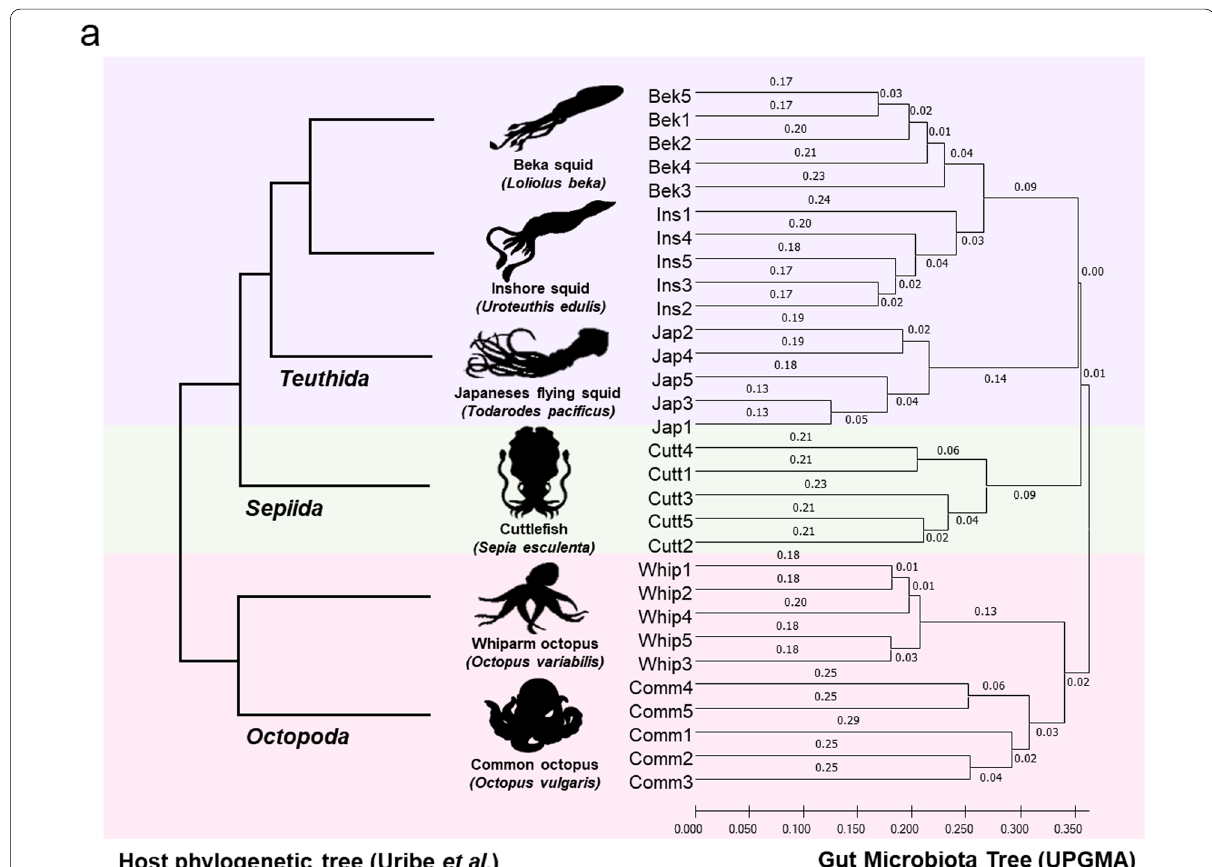
Fig. 3 Phylosymbiotic host‑gut microbiota assembly in cephalopods. a UPGMA‑clustering dendrograms for cephalopod gut microbiomes based on unweighted UniFrac distances, compared with the host phylogenetic tree based on complete host mitochondrial genomes reported by Uribe et al. [21]. Species of respective orders of cephalopods are depicted with a specific background color. Abbreviations: Cutt, cuttlefish; Bek, beka squid; Ins, Inshore squid; Jap, Japanese flying squid; Whip, whiparm squid; Comm, common